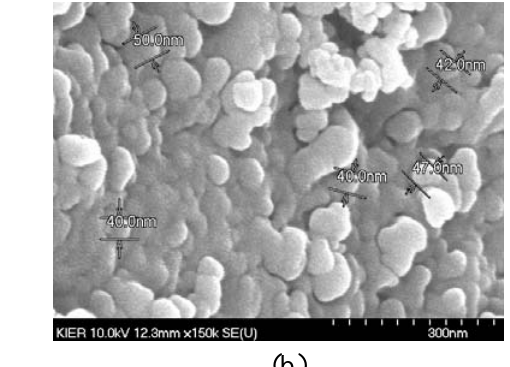
Figure 2. SEM photograph of (a) F-doped SnO